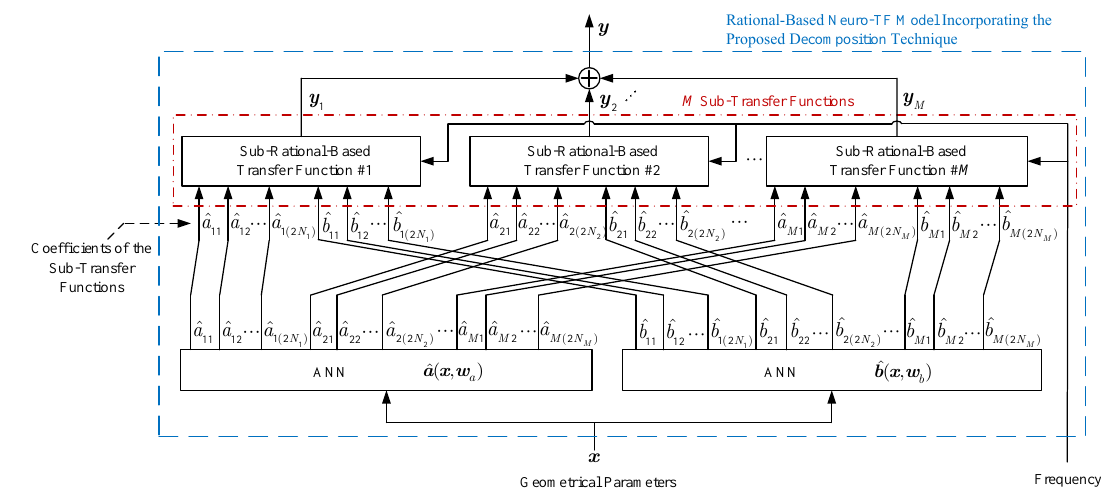
Figure 1. Structure for the rational-based neuro-TF model incorporating the proposed decomposition